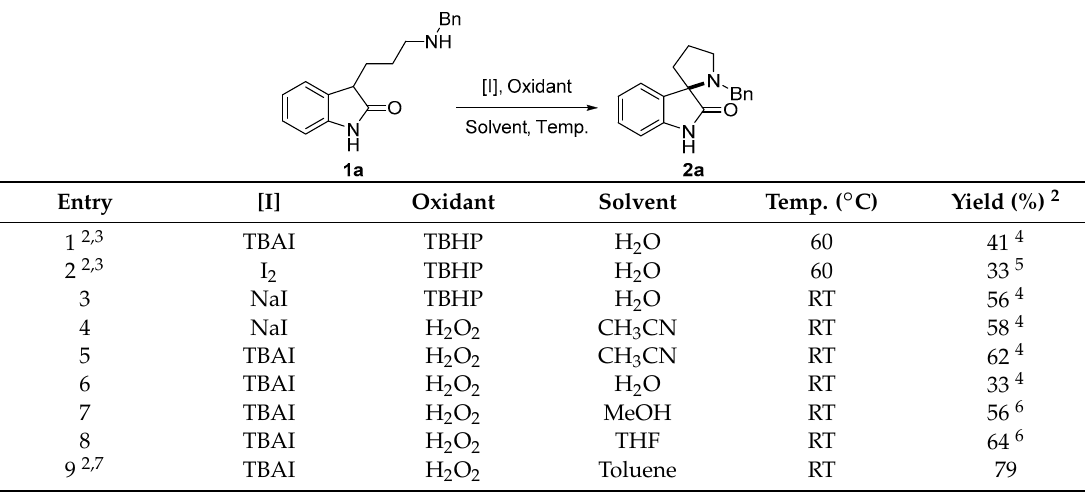
Table 1. Studies and optimization of the reaction paramaters 1 .